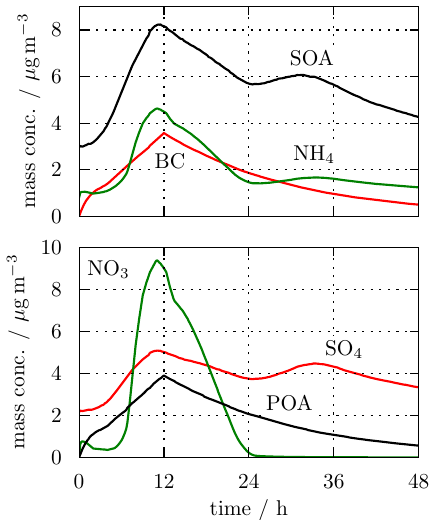
Fig. 6. Evolution of bulk aerosol species for the urban plume case.